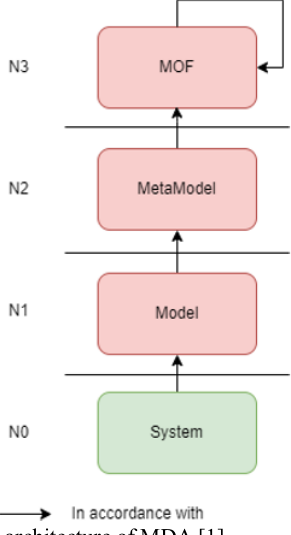
Fig. 1. The 4-level architecture of MDA [1].